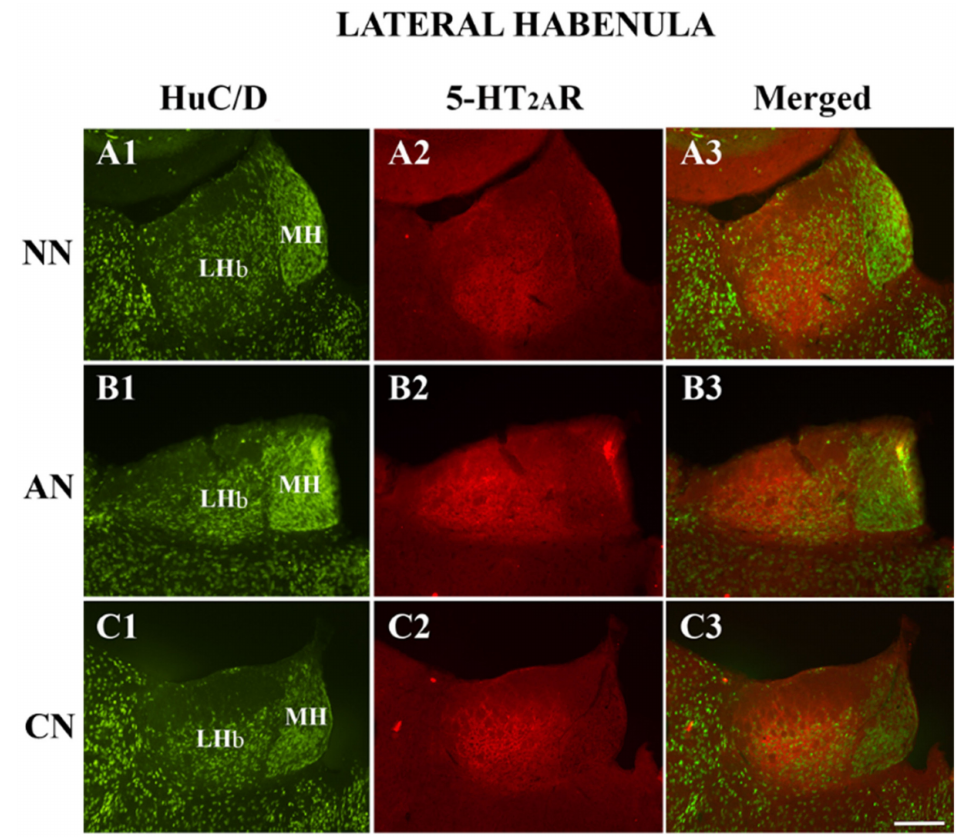
Figure 2. Colocalization of the HuC / D (pan-neuronal marker) with 5-HT 2A receptor (5-HT 2A R) in the lateral habenula of naive nicotine (A1–A3), acute nicotine (B1–B3) and chronic nicotine (C1–C3) rats. Double immunofluorescence images showing HuC / D in green (left column pictures; A1, B1, C1), 5-HT 2A R in red (middle column pictures; A2, B2, C2), and colocalization of HuC / D with 5-HT 2A R in yellow (right column merging pictures; A3, B3, C3). Note the high 5-HT 2A R immunoreactivity in the LHb of acute nicotine rats. See text and Table 2 for explanations. Abbreviations: NN, naïve nicotine; AN, acute nicotine; CN, chronic nicotine; LHb, lateral habenula; MH, medial habenula. Scale bar = 200 µ m in C3 (applies to